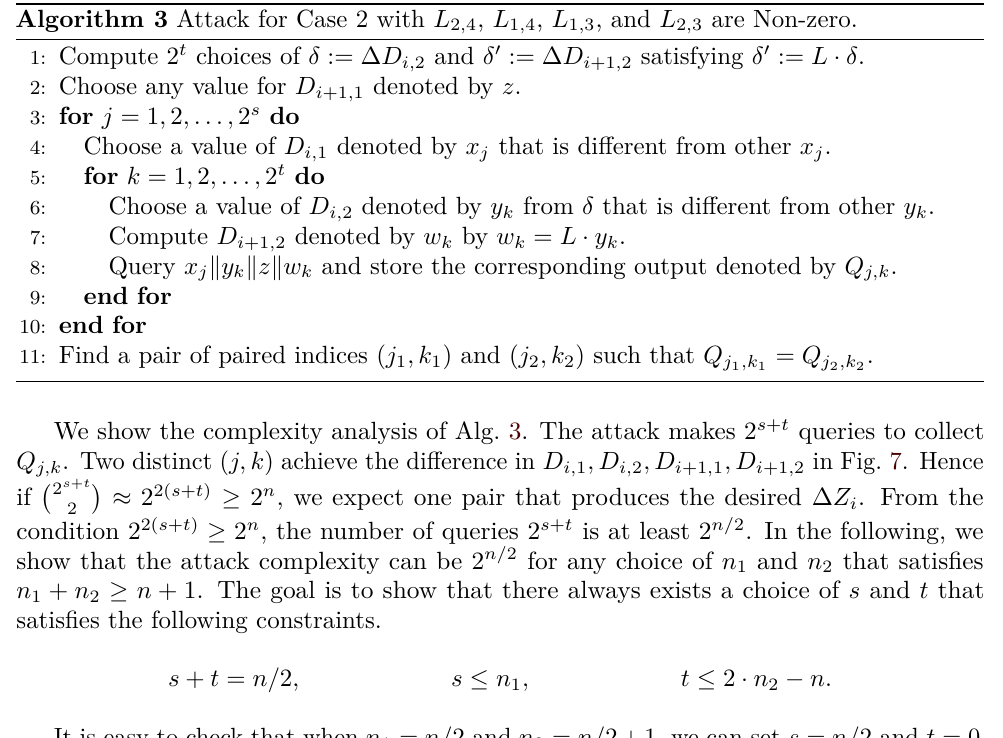
The number of choices of such δ and δ 0 depends on the parameter n n 2 ≥ n/ 2 + 1, the number of choices is at least 2 2 · n 2 − n . Thus, we can exploit the birthday- paradox like effect of size at most 2 2 · n 2 − n . Unlike in the previous cases, δ and δ 0 cannot